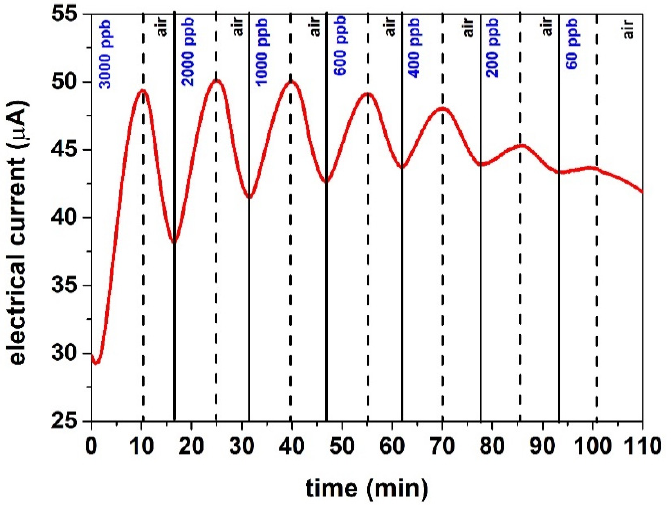
Figure 5. Electrical current variation of a NiO:Al film prepared with 4% O 2 in plasma, as a function of time for different O 3 concentrations, at 110 °C.